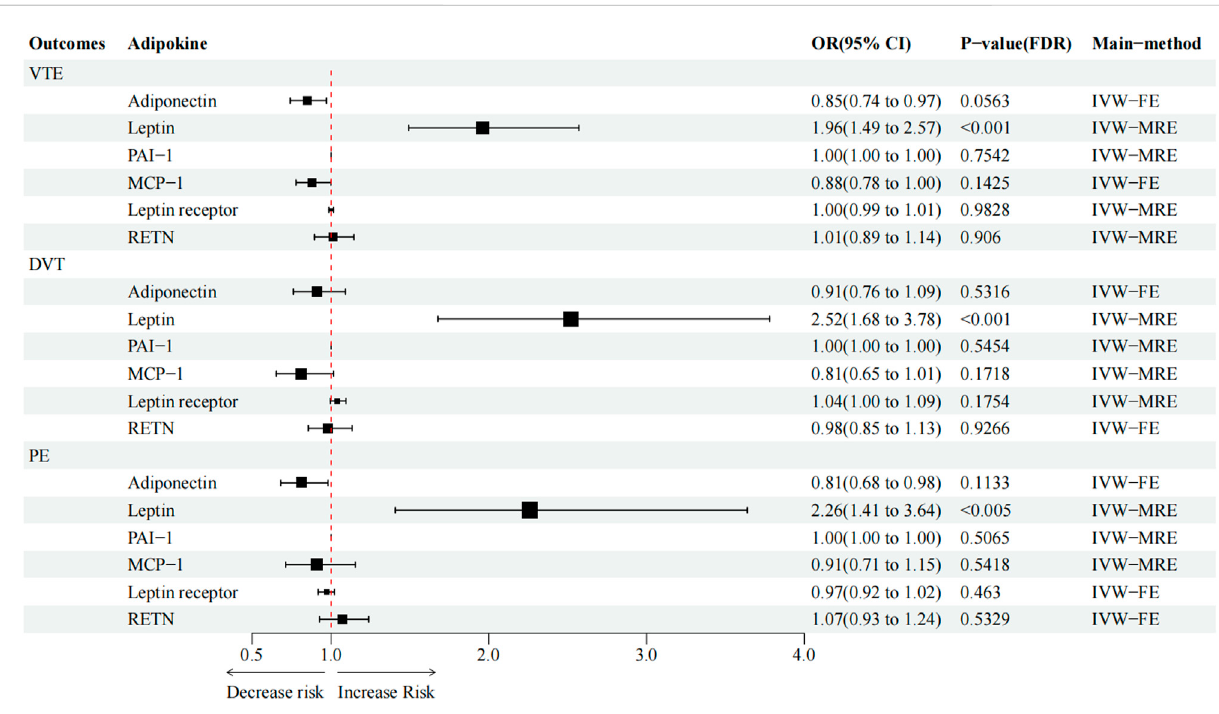
FIGURE 2 Causal effect of circulating adipokine concentrations on and VTE, DVT, and PE. OR, odds ratio; CI, con fi dence interval; IVW, inverse variance weighted; RE, random-effects; FE, fi xed-effects.